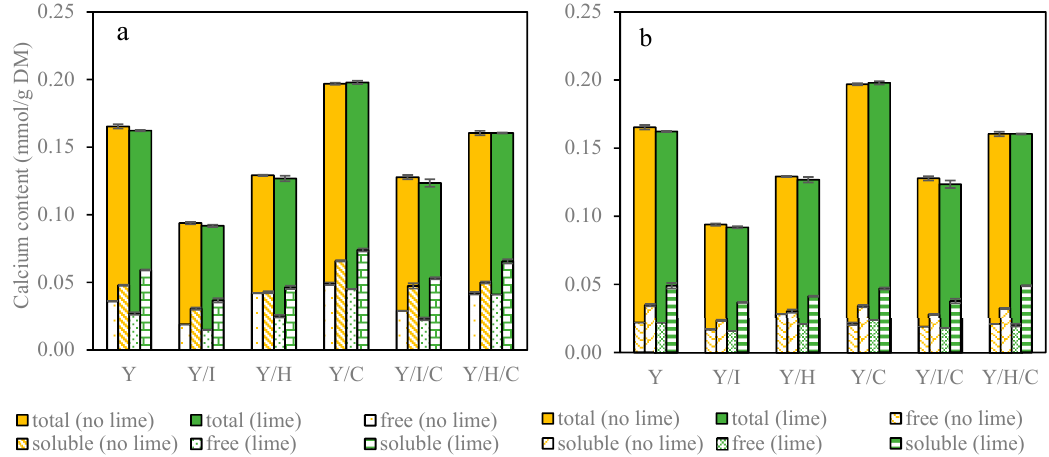
Figure 1. Calcium content per gram dry matter of snacks by adding lime juice ( a ) at the beginning; ( b ) at the end of intestinal phase.